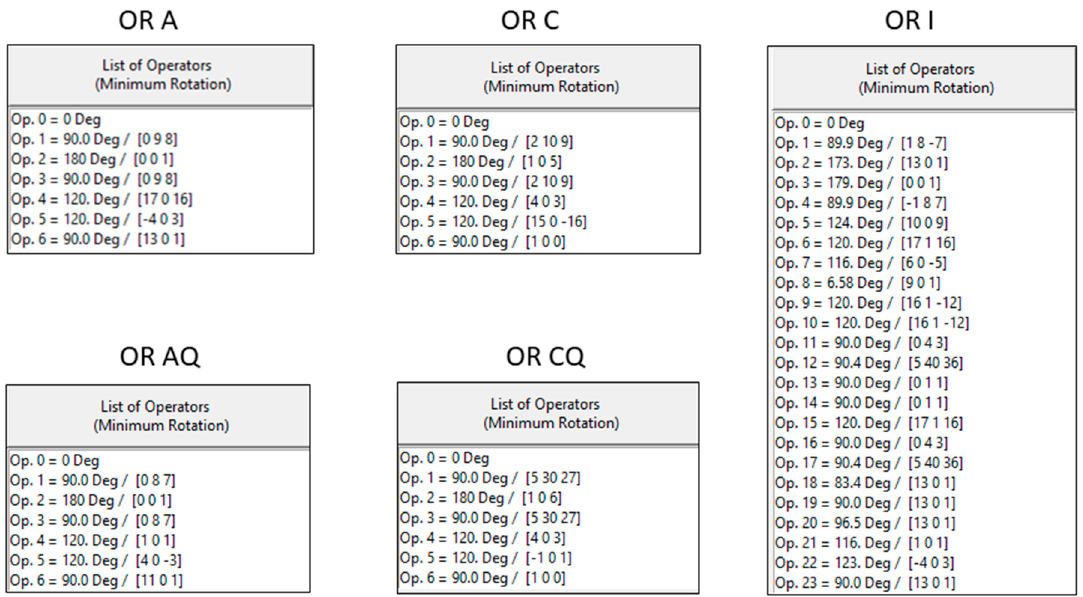
Figure 10. Lists of operators (represented by the disorientation angle and B19 ′ rotation axes) for the different ORs investigated in the present study.